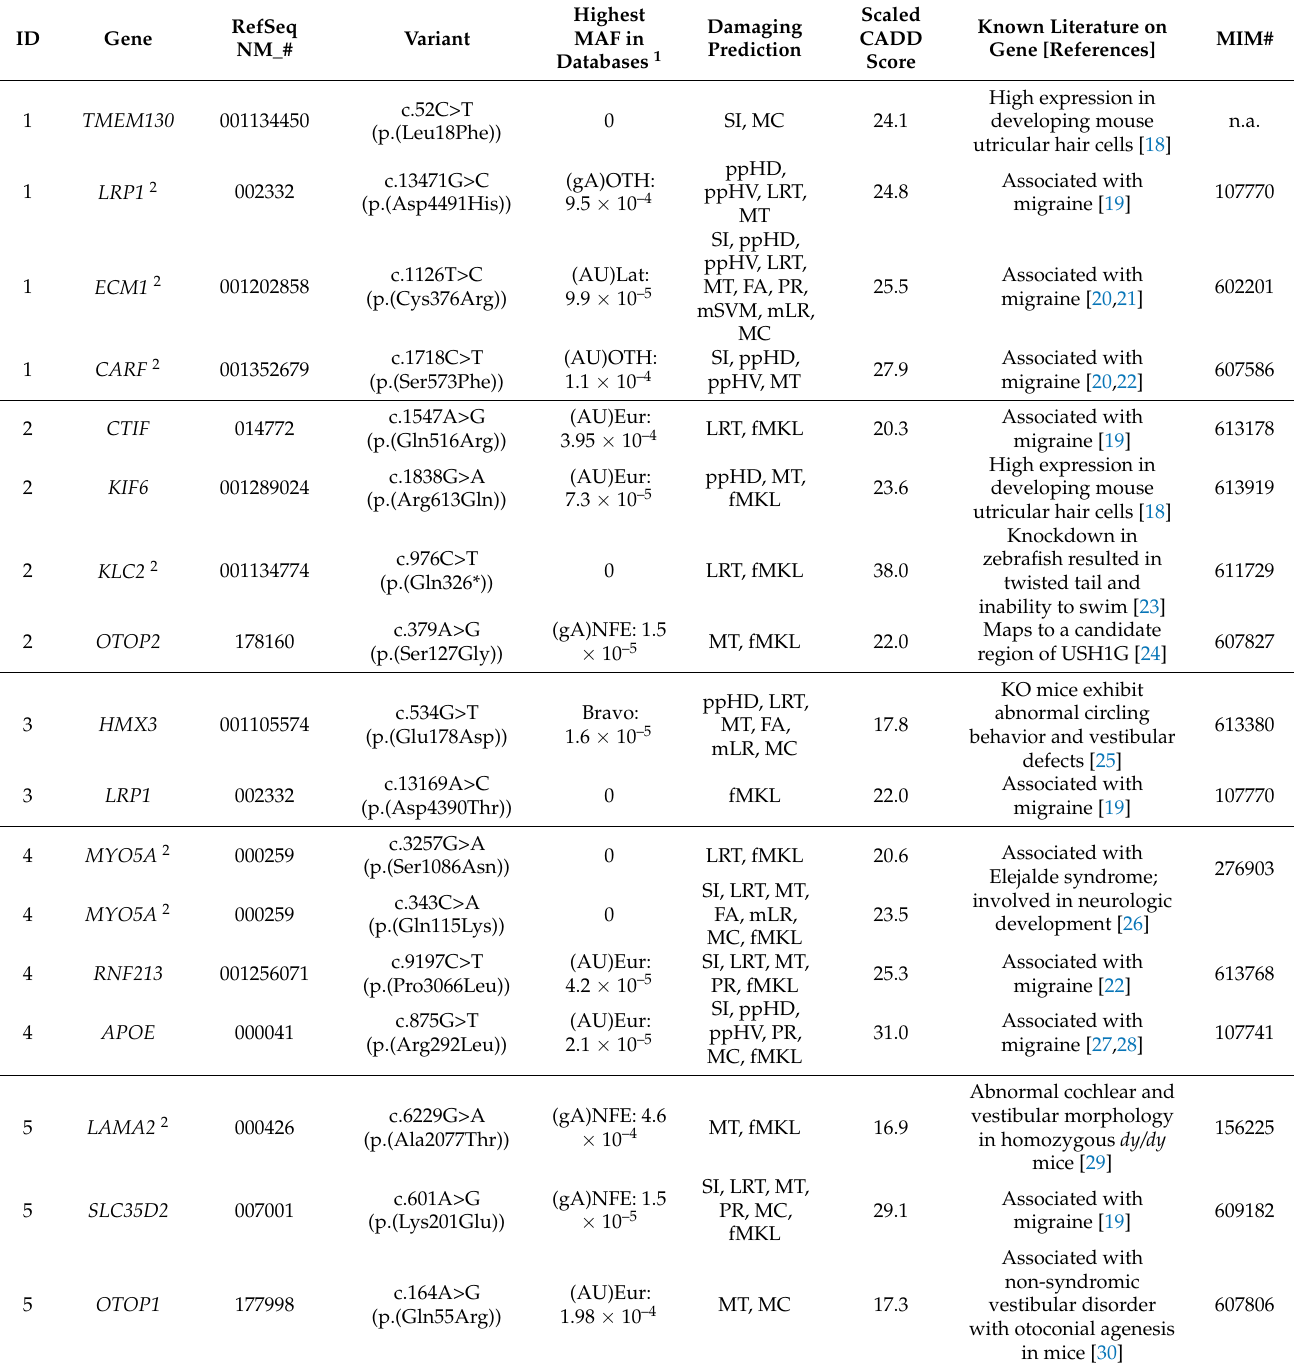
Table 2. Genetic variants identified in children with peripheral vestibular